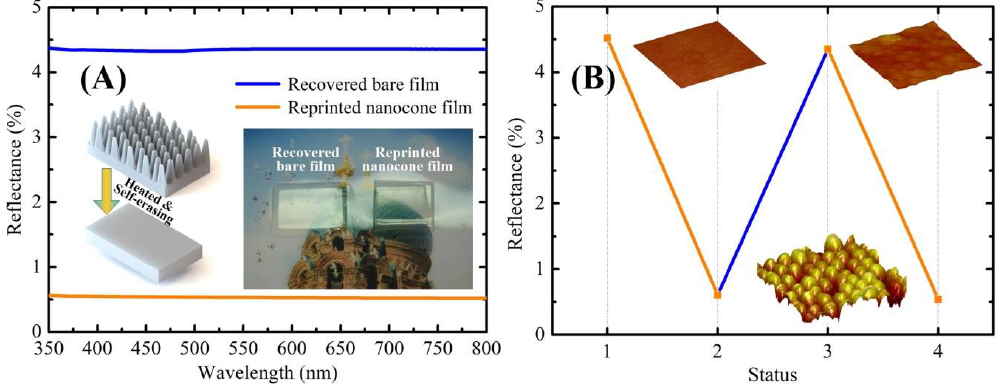
Figure 5. ( A ) Reflectance measurements of recovered bare PVA film and reprinted nanocone PVA film obtained for the light incident vertically (Inset figures show macroscopic optical images of the corresponding recovered bare film and reprinted nanocong film upon the color picture); and, ( B ) Reflectance of a PVA film with nanocone arrays under a shape memory cycle (Insets show the AFM images of the PVA film with three states, including original surface, reprinted nanocone arrays, and recovered